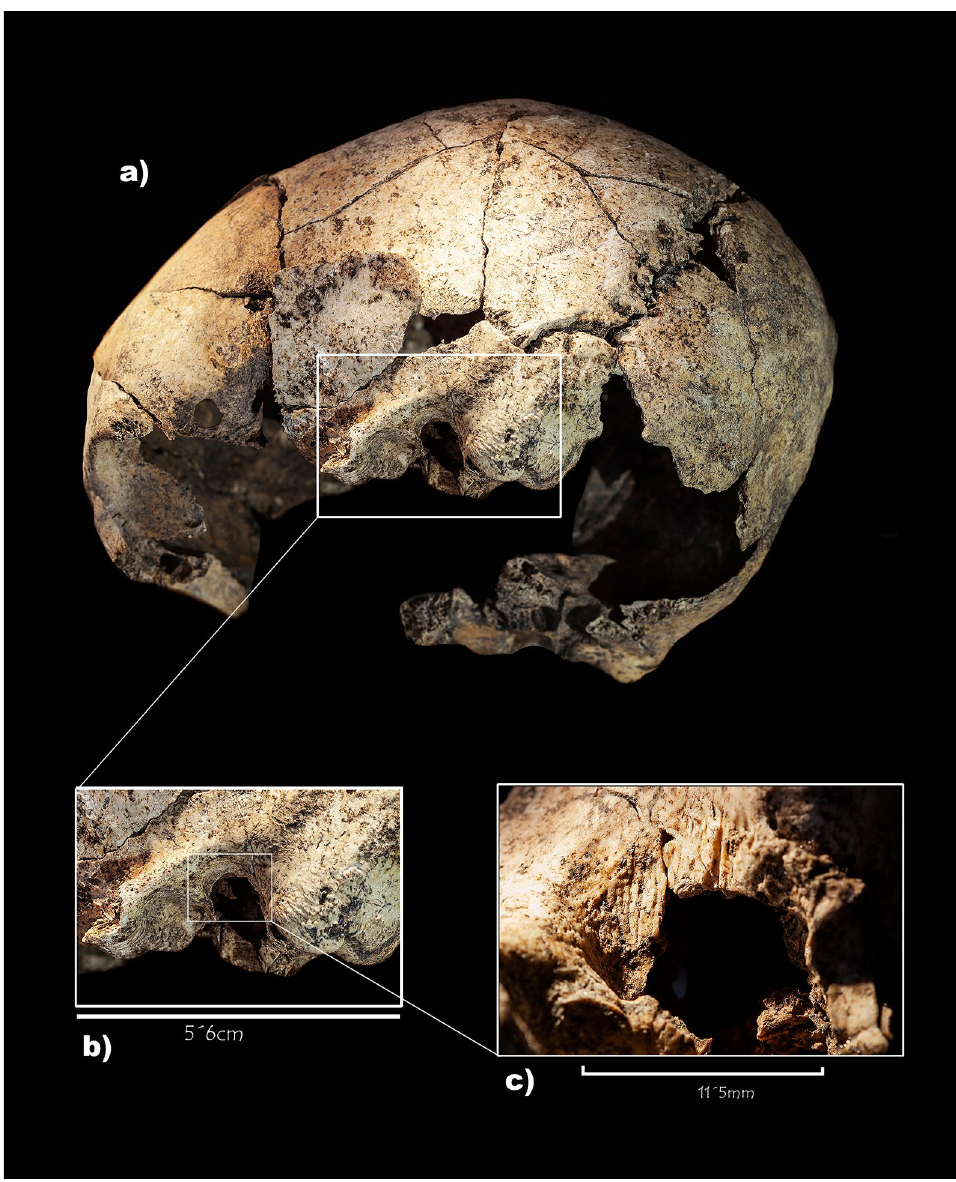
Figure 5. Set of cut marks identified on the left temporal bone of the skull under study. Lateral view of the left side of the skull ( a ), detail of the left temporal bone with the otological surgery ( b ), and enlarged image of the cut marks located at the anterior edge of the surgical trepanation made in the left ear, next to the mastoid process ( c